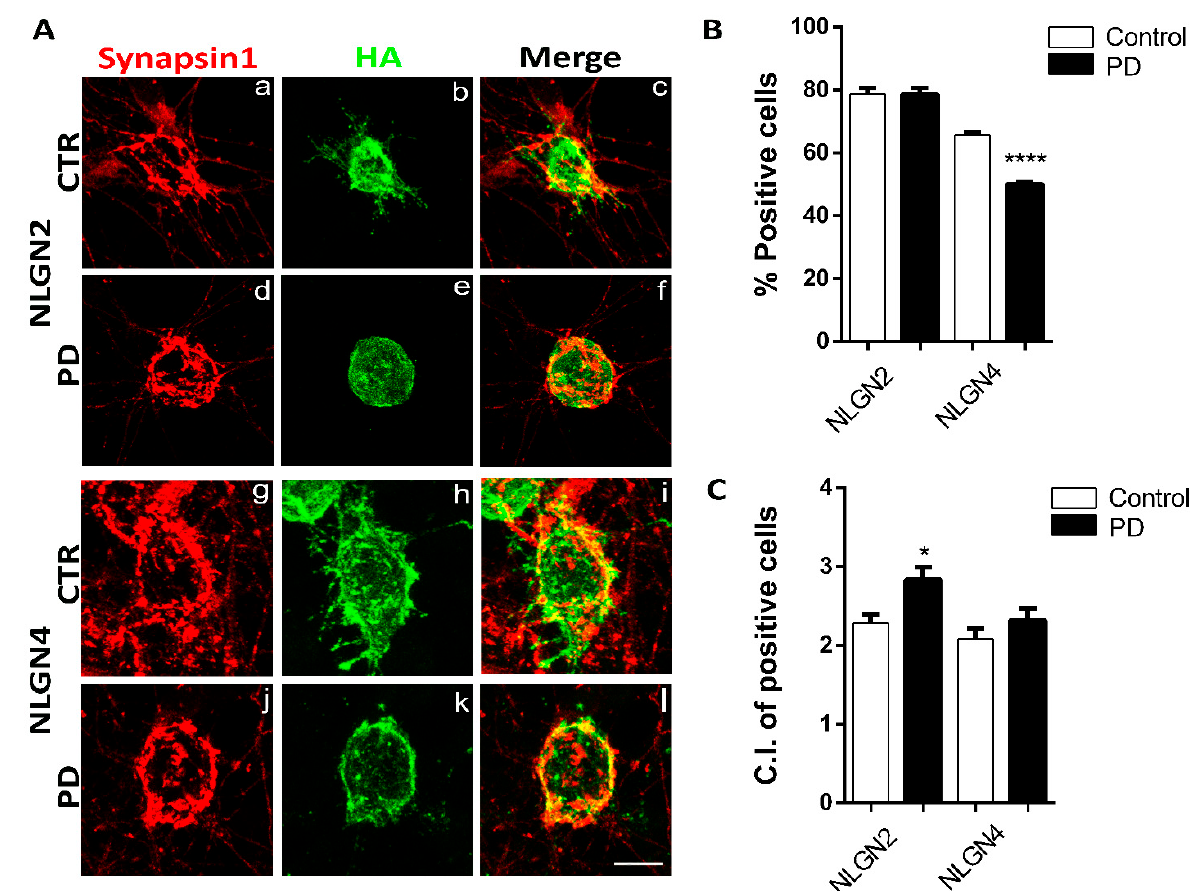
Figure 4. Heterologous synapse formation assays in PD neurons. ( A ) Representative immunofluorescence images of control and PD neurons co-cultured with HEK293T cells transfected either with NLGN2-HA ( a – f ) or NLGN4-HA plasmids ( g – l ). The co-cultures were stained with antibodies to HA epitope (green) and the presynaptic marker Synapsin 1 (red) and coincident green and red signals are shown in yellow. Scale bar = 50 µ m (applies to all images). ( B , C ) Summary graphs showing the percentage of HEK293 positive cells for Synapsin 1 ( B ) and their C.I. of ( C ) when co-cultured with iPSC-derived neurons (NLGN2-HA Control: n = 68 cells of 85 cells/2 cultures; PD: n = 108 cells of 135 cells/3 cultures, NLGN4-HA Control: n = 50 cells of 77 cells/2 cultures; PD: n = 74 cells of 147 cells/3 cultures). All data represent mean ± SEM; statistical comparisons were made with two tailed t -test (* p = 0.01; **** p < 0.001).